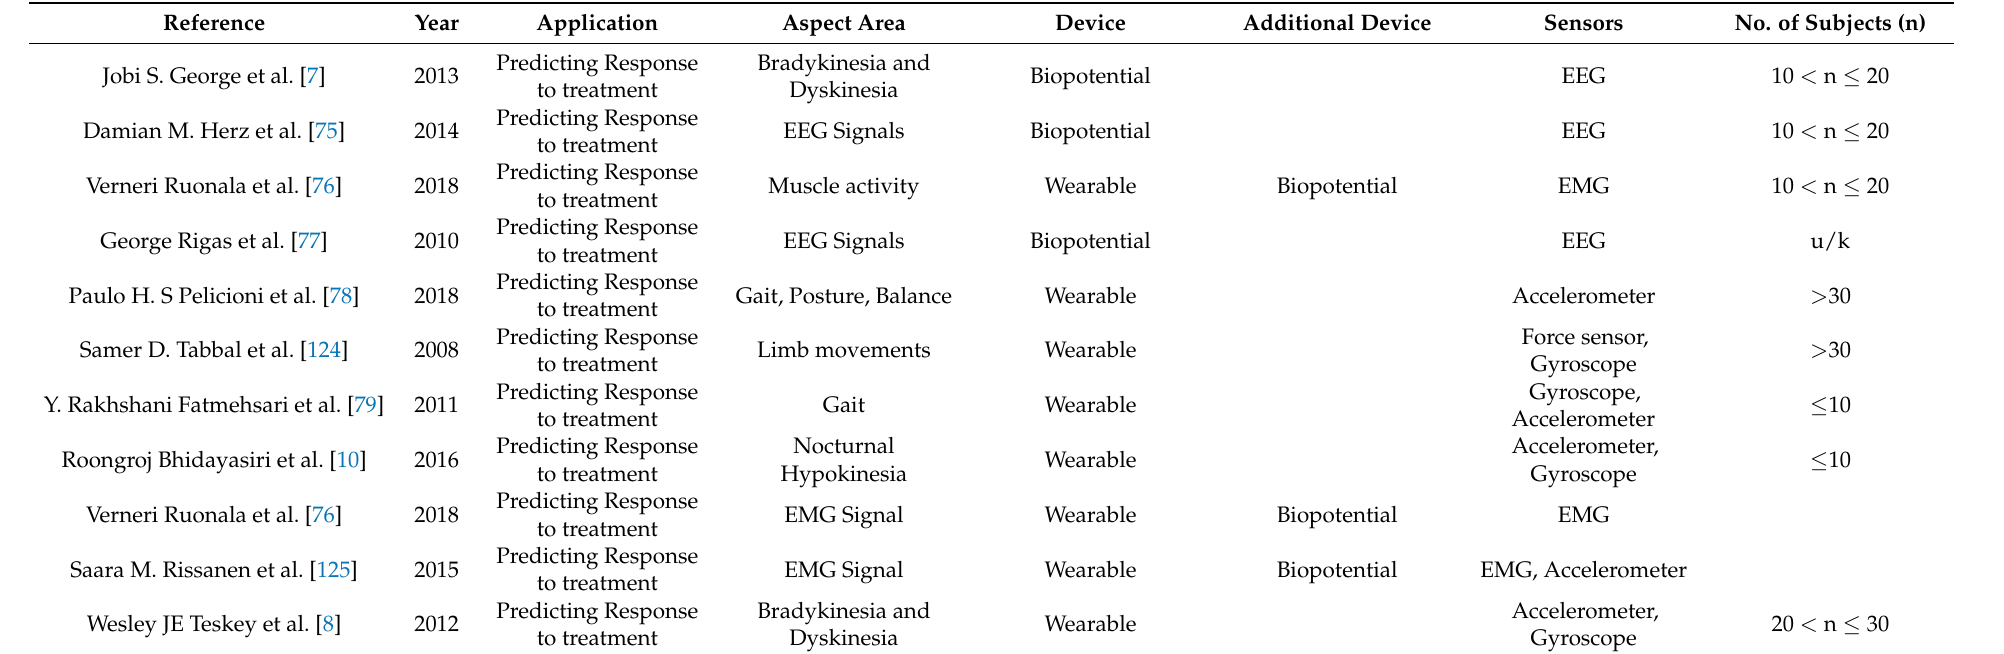
Table A1. Papers about predicting response to treatment.